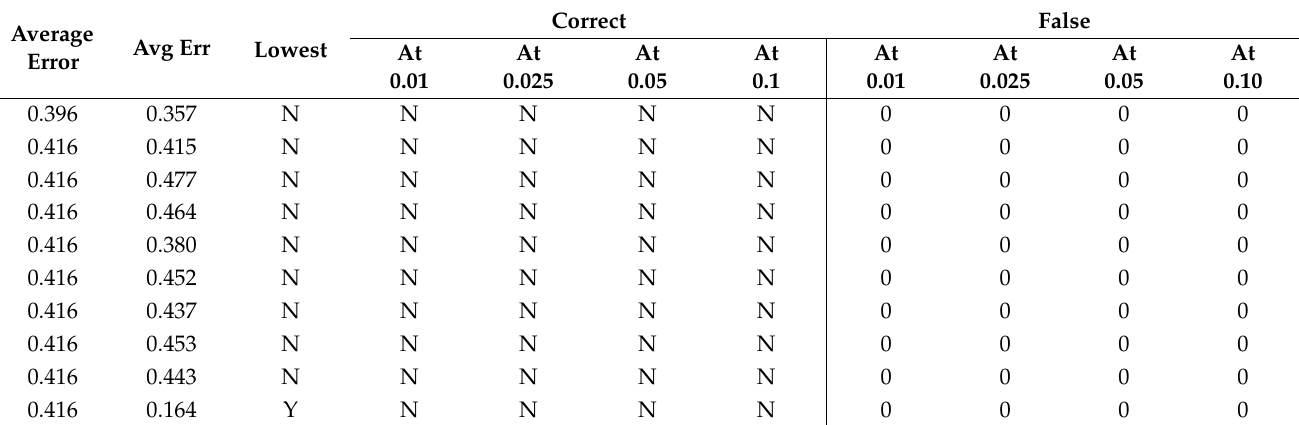
Table 9. Set 3, trials 11–20 summary data (all 0.5 PR values).